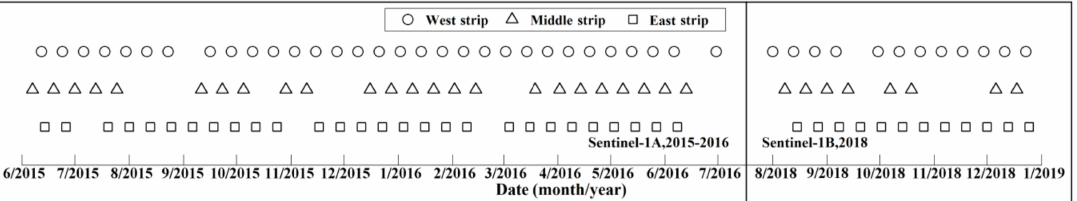
Figure 2. Temporal distributions of the Sentinel-1 images acquisition (month /